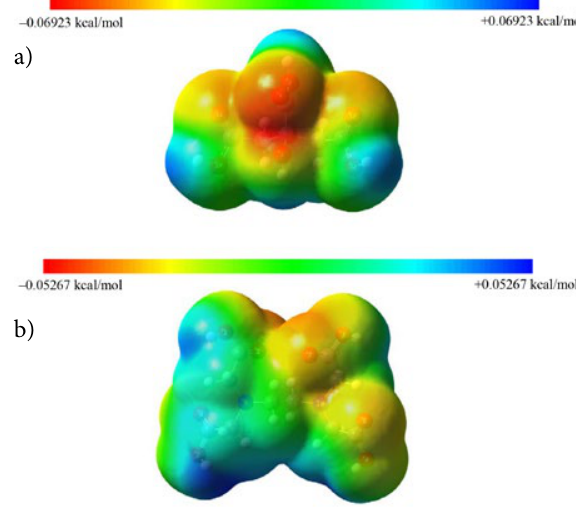
Fig. 2. The electrostatic potential map of (a) CA and (b) EDTA. Isovalue of electron density = 0.0002 au (e/a °3 ). Refer to figure 1 for the structures without the